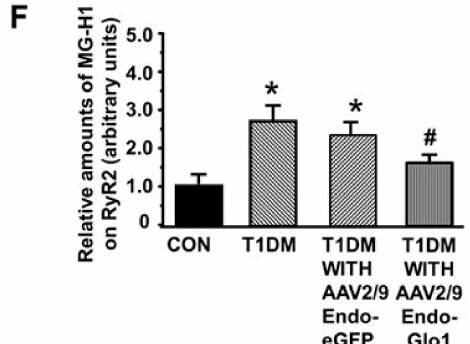
Figure 7. MG-H1 levels in ventricular tissues. ( A ) shows images of immuno-fluorescence staining for MG-H1 in cardiac myocytes and cSMCs from the control, T1DM, AAV2 / 9-Endo-eGFP-treated T1DM, and AAV2 / 9-Endo-Glo1-treated DM rats. Red arrow emphasizes the di ff use staining associated with eGFP expression. Graphs below in ( B ) and ( C ) are mean ± S.E.M. for n ≥ 30- sections obtained from n = 4–6 animals per group. ( D ) shows Coomassie-stained SDS-PAGE cell for the autoradiogram for MG-H1 in ventricular homogenates ( E ) from the control, AAV2 / 9- T1DM, AAV2 / 9-Endo-eGFP-treated T1DM, and AAV2 / 9-Endo-Glo1-treated T1DM rats. Bar chart graph in Panel ( F ) is mean ± S.E.M from ventricular homogenates from n = 3–5 rats done in duplicates. * denote significantly di ff erent from the control ( p < 0.05), # denote significantly di ff erent from T1DM ( p < 0.05). Bar at bottom of each image = 50 µ